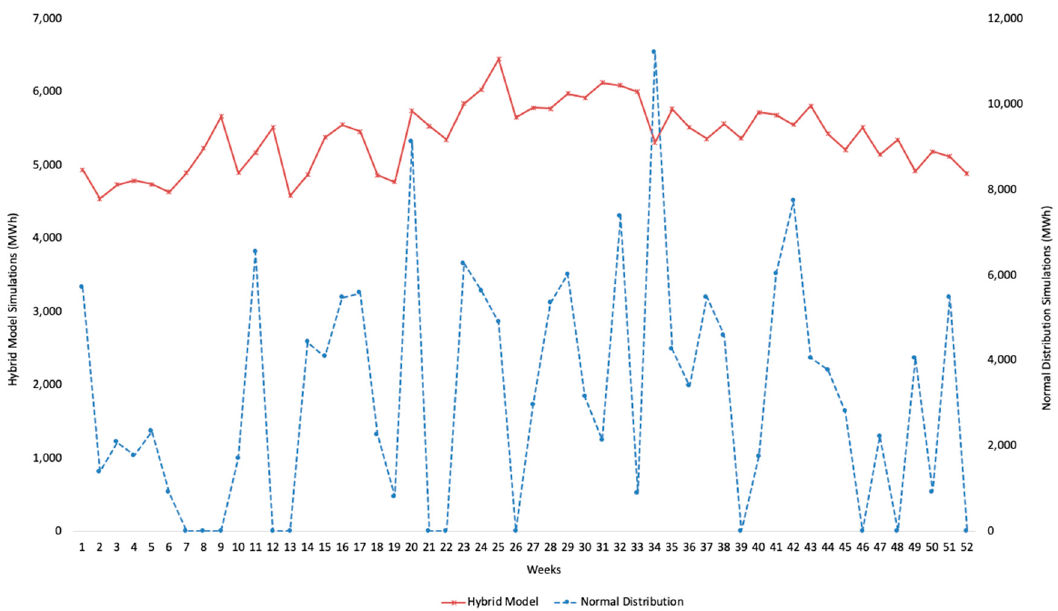
Figure 9. Comparison between instances generated by the hybrid model vs. normal distribution.